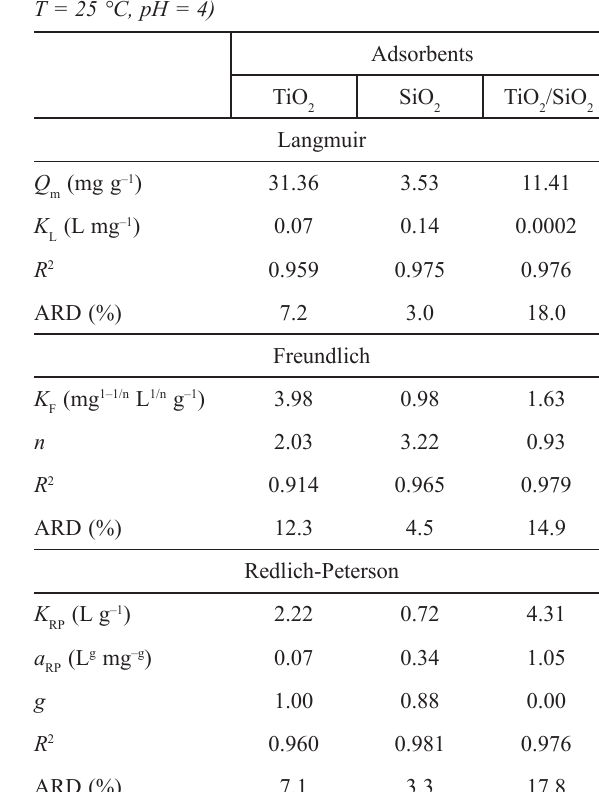
Table 2 – Isotherm parameters of Langmuir, Freundlich, and Redlich-Peterson models (Adsorbent loadings = 0.1 g L –1